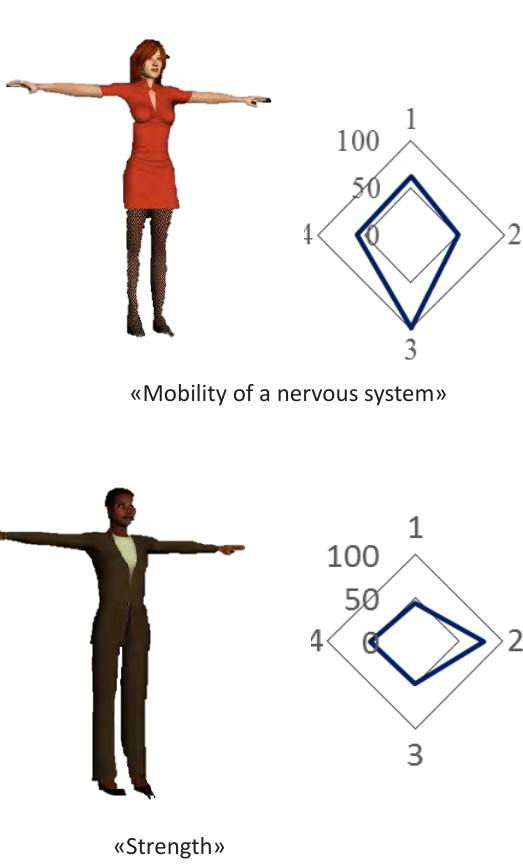
Fig. 2. The examples of individual factorial structure of functional and psycho-physiological opportunities at athletes: results of mathematical and visual 3D-modeling: 1 – Factor «Parasympathicotonia»; 2 – Factor «Strength»; 3 – Factor «Mobility of a nervous system»; 4 – Factor